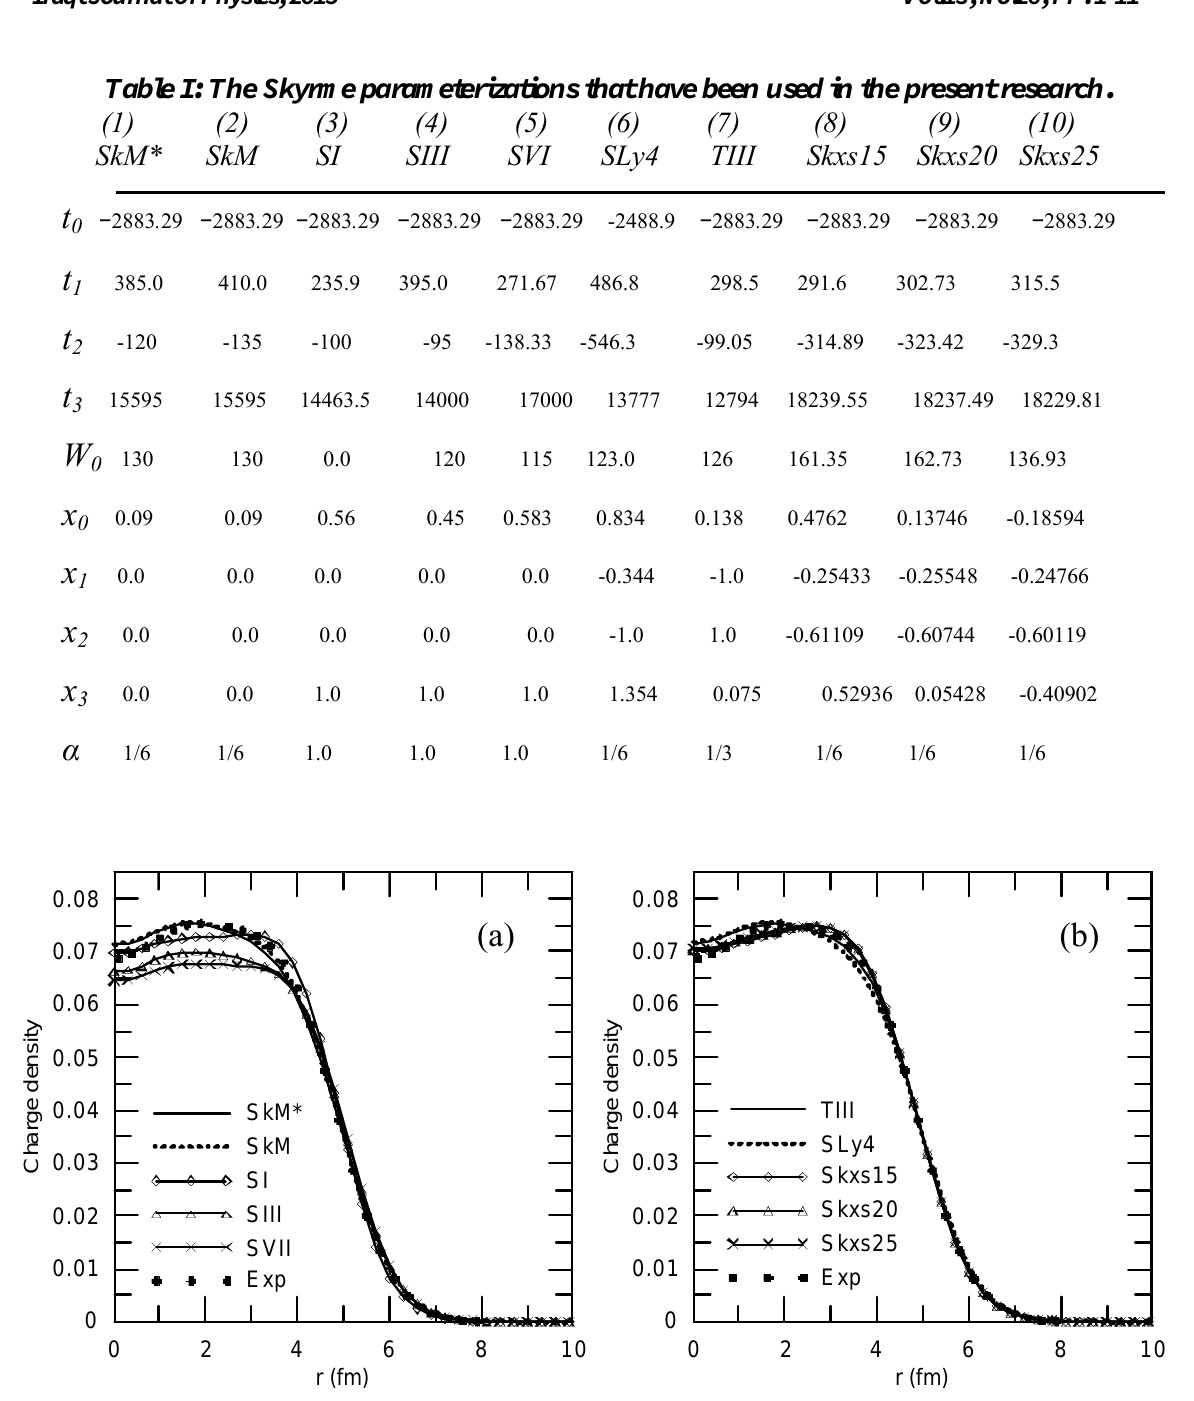
Fig.1: Charge density distribution for 92 Mo using different Skyrme parameterizations